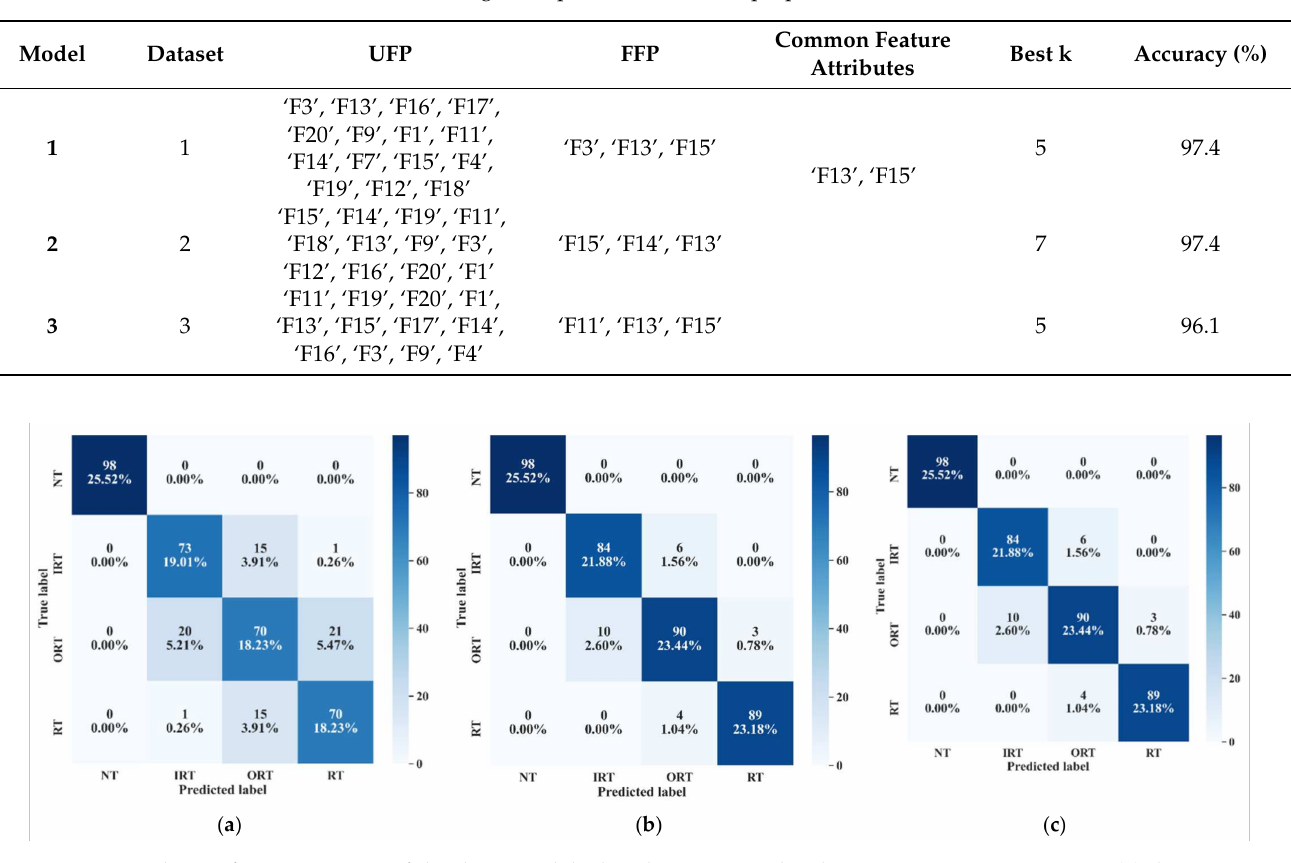
Figure 19. The confusion matrices of the three models that demonstrate the class-wise test accuracies, i.e., ( a ) dataset 1, ( b ) dataset 2, and ( c ) dataset